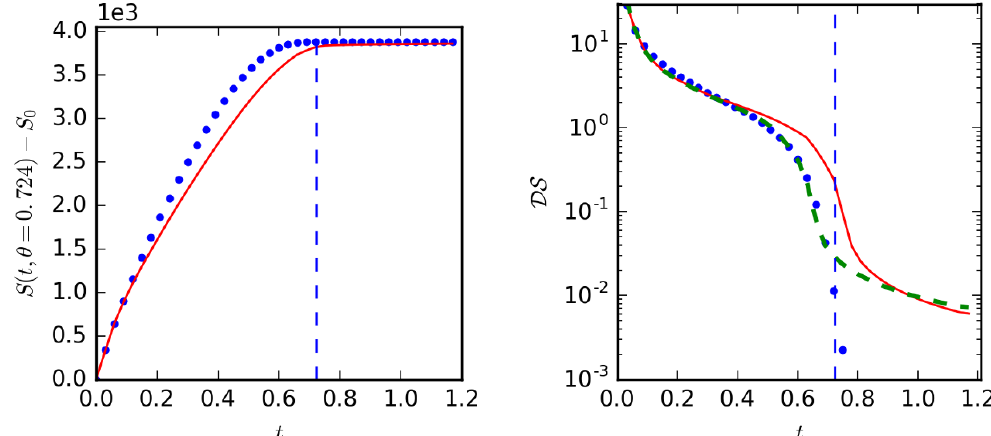
Figure 7 . Entanglement entropy (with t = 0 contribution subtracted, left) and its logarithmic time derivative (right) after a quench as a function of time for a polar cap of size 0 : 724 rad. On the left, the blue points correspond to N = 200 with (cid:22) = 2000 and the red line is an interpolation of the results for (cid:22) = 20 (scaled for comparison). On the right, the blue points correspond to N = 200 with (cid:22) = 2000, the red line is an interpolation of the results for (cid:22) = 20. For comparison, the green dashed curve is an interpolation of results for (cid:22) = 20, N = 203 for a polar cap of size 0 : 623 rad. The vertical blue dashed line corresponds to t = 0 : 724.